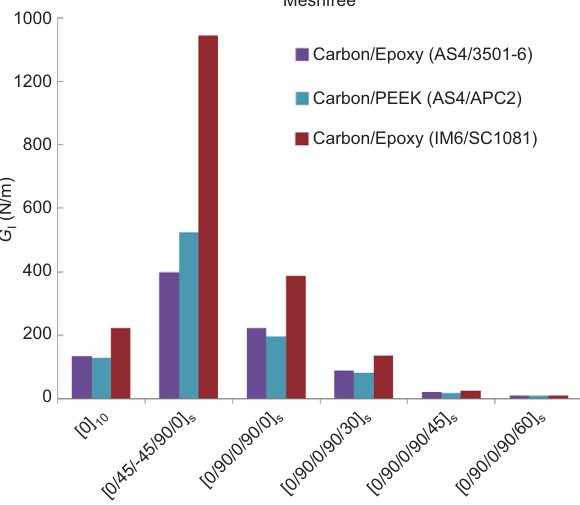
Figure 15 Energy release rates for various orientation angles (continuous).